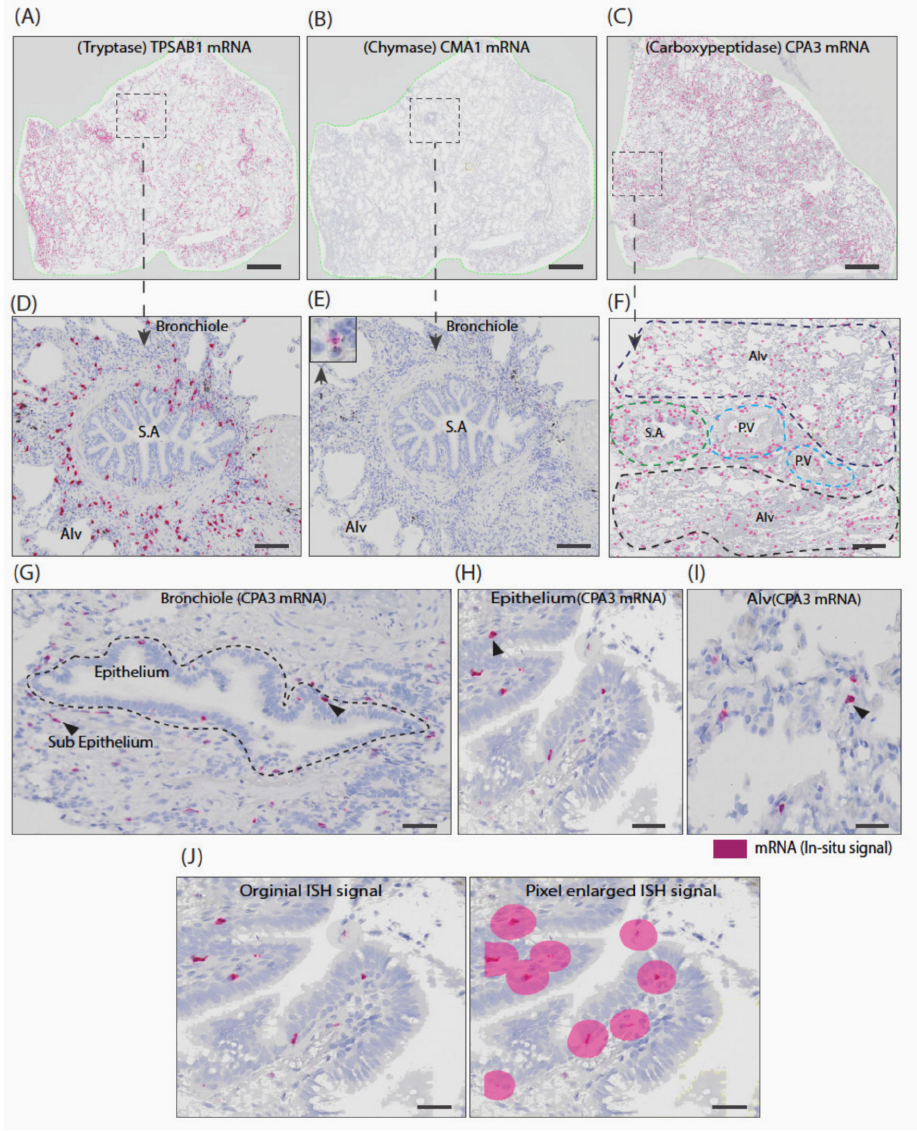
Figure 5. Overview graphic comparisons between tryptase, chymase and CPA3 mRNA expression level and their general spatial distribution in non-diseased lung anatomical regions. ( A – C ). Low-magnification overview micrographs of chromogenic in situ hybridization (CISH)-stained lung sections for tryptase (TPSAB1), chymase (CMA1) and carboxypeptidase (CPA3) mRNA. Note that, to allow low-magnification visualization of cells with 10 µ m diameters within large cm 2 -size sections, all three markers of ISH signals were enlarged uniformly (as illustrated in J ). CPA3 mRNA level was similar to the tryptase (TPSAB1) mRNA, whereas chymase (CMA1) mRNA was scarcely found. ( D – F ). Zoomed-in areas further illustrate the striking difference in mRNA levels between chymase (CMA1) and CPA3, despite the fact that these are strongly linked at a granule protein level. ( G – I ) Examples of original CPA3 ISH signals in bronchiolar and alveolar lung compartments. It is very evident that CPA3 mRNA-expressing mast cells are not restricted to certain lung anatomical regions. ( J ) Images illustrating the original ISH signals being enlarged (using Visiopharm software) used in ( A – F ). Scale bars ; ( A – C ) = 200 µ m; ( D – E ) = 300 µ m; 40 µ